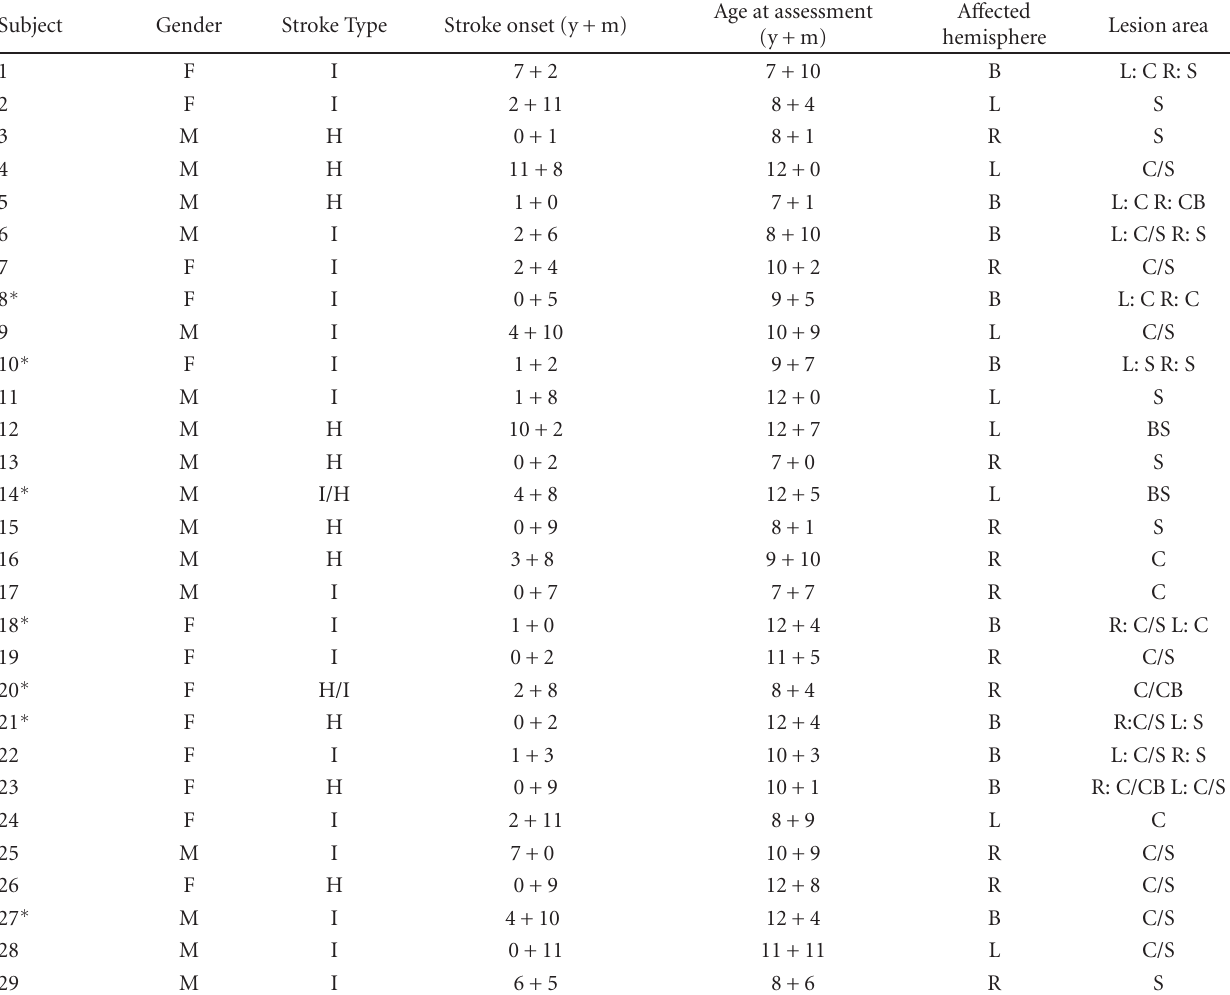
Table 1: Experimental group characteristics.